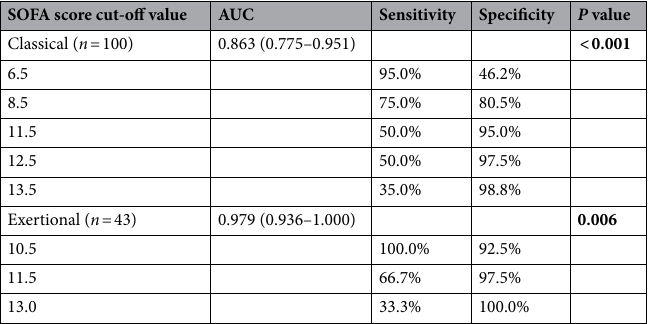
Table 4. Results of receiver operating characteristic analysis of SOFA scores for 28-day mortality in classical and exertional cases. SOFA sequential organ failure assessment; AUC area under the curve. Significant values are in